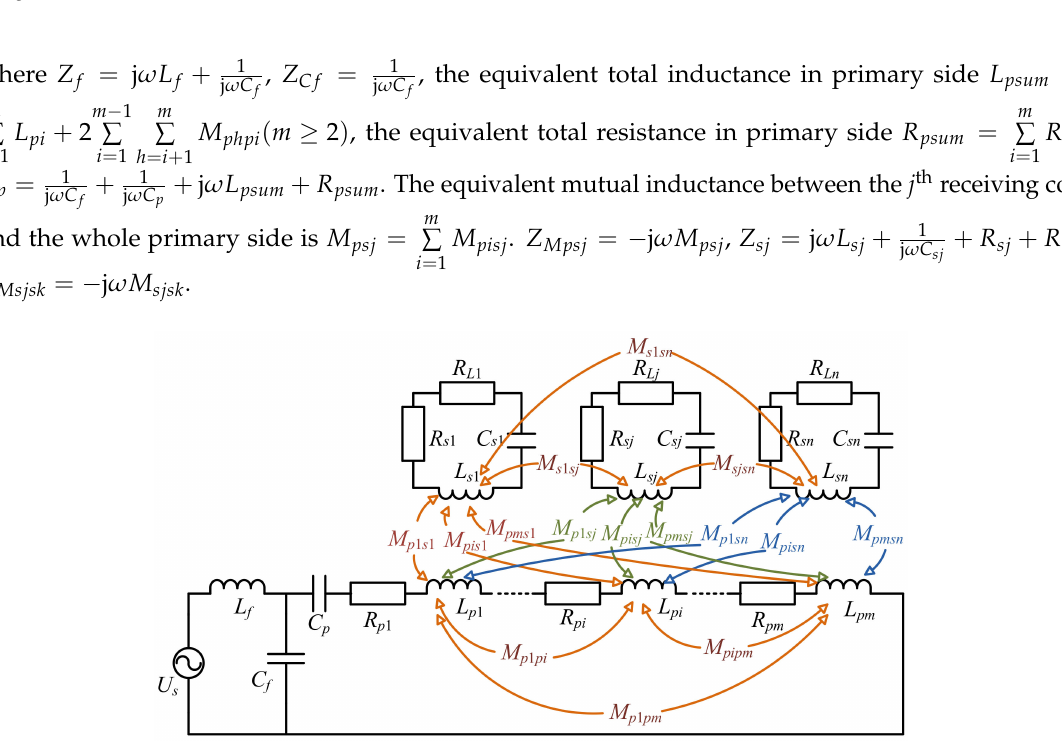
Figure 3. The general circuit model of the wireless power transfer system with multiple transmitters and multiple